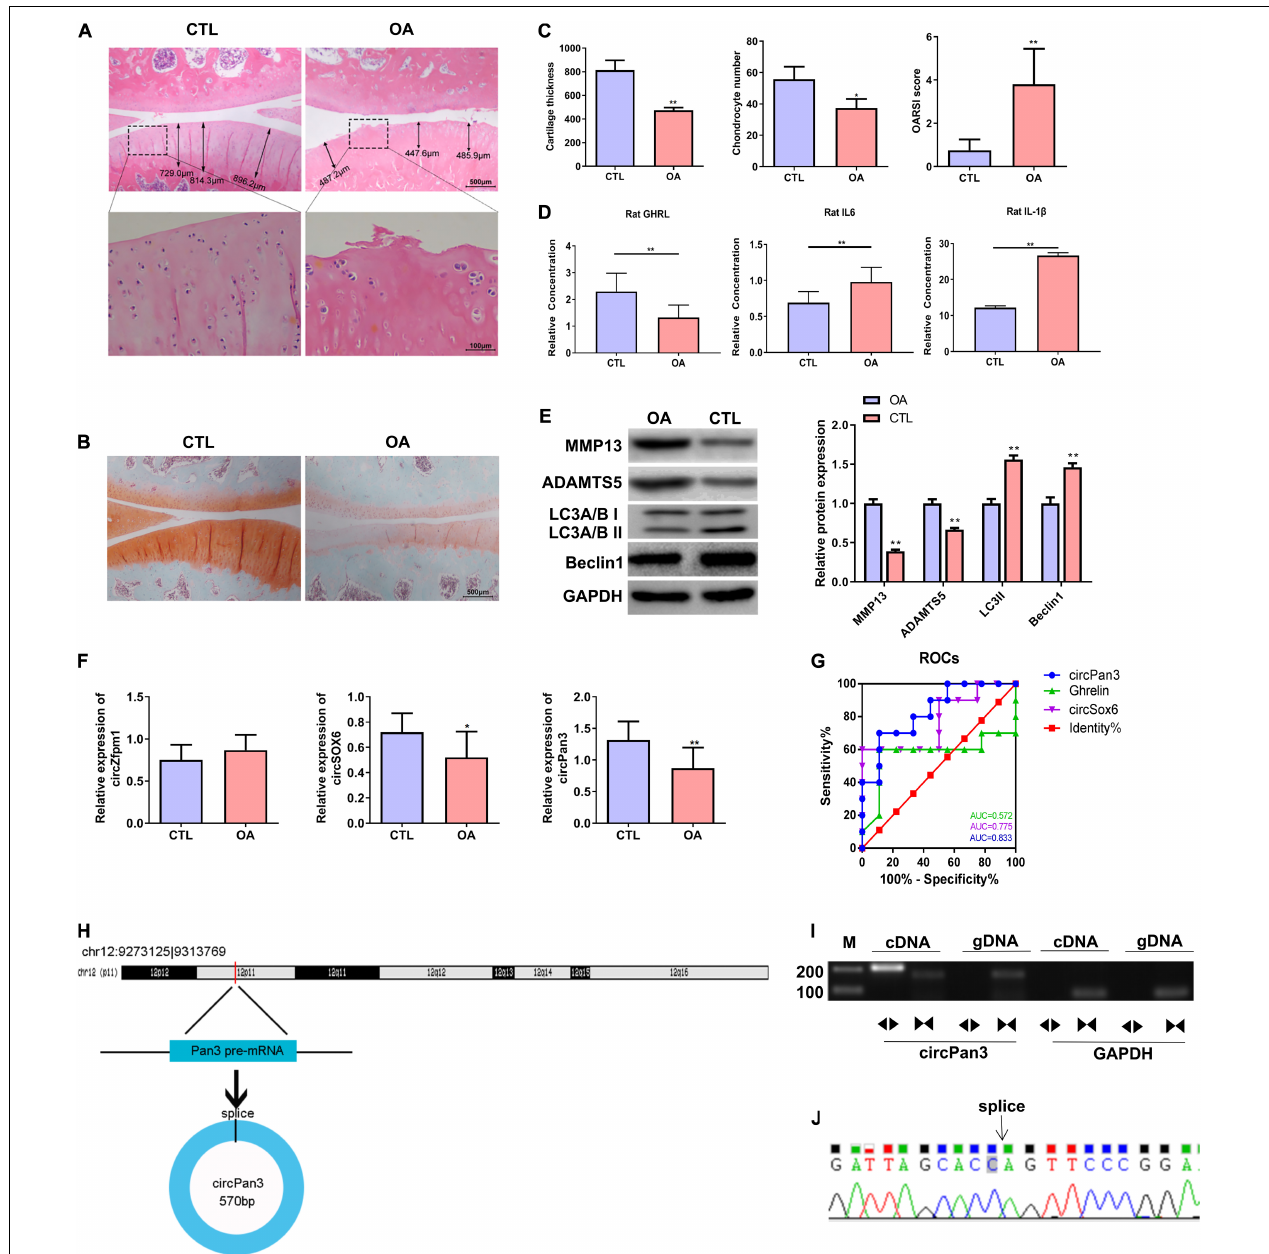
FIGURE 4 | Decreased circPan3 expression, ghrelin synthesis, and autophagy in the rat OA model. (A) Histological alterations of knee joint cartilage tissues in OA and CTL rats. The rat cartilage tissues were subjected to H&E staining. Rats that underwent the sham operation were used as the control group (CTL). (B) Safranin O/fast green staining of knee joint cartilage tissues from both groups. (C) The analysis results of cartilage thickness, chondrocyte density, and OARSI scores in knee joint tissues from both groups. (D) Plasma GHRL, IL-6, and IL-1 β levels in both groups. The ELISA method was used to determine the levels of these factors. (E) Western blotting results of MMP13, ADAMTS5, beclin 1, and LC3 in the cartilage tissues of rats from both groups. (F) The expressions of circZfpm1, circSox6, and circPan3 in the knee joint cartilage tissues of rats in the OA model group. The relative expression levels of circRNAs were measured by RT–qPCR. (G) ROC curve analysis of circPan3, circSox6, and ghrelin as potential biomarkers of OA pathogenesis. (H) Bioinformatics predicted that circPan3 was formed from the back-splicing of Pan3 encoded pre-mRNA, which is located at chromosome 12. (I) Validation of the formation of circPan3 in rat chondrocytes. RT–PCR was carried out using divergent and opposite-directed primers and cDNA and gDNA as the templates. (J) Confirmation of the splice joint site of circPan3 in rat chondrocytes was assessed by DNA sanger sequencing. The joint site was indicated by an arrow. CTL, control; OA, osteoarthritis; OARSI, Osteoarthritis Research Society International; GHRL, ghrelin; IL-6, interleukin-6; IL-1 β , interleukin-1 β ; MMP13, matrix metallopeptidase 13; ADAMTS5, ADAM metallopeptidase with thrombospondin type 1 motif 5; GAPDH, glyceraldehyde-3-phosphate dehydrogenase; RT–qPCR, quantitative real-time polymerase chain reaction; RT–PCR, reverse transcription polymerase chain reaction; ELISA, enzyme linked immuneSorbent assay; ROC, receiver operating characteristic; cDNA, complementary DNA; gDNA, genomic DNA. * P < 0.05; ** P < 0.01 versus CTL, n = 3.